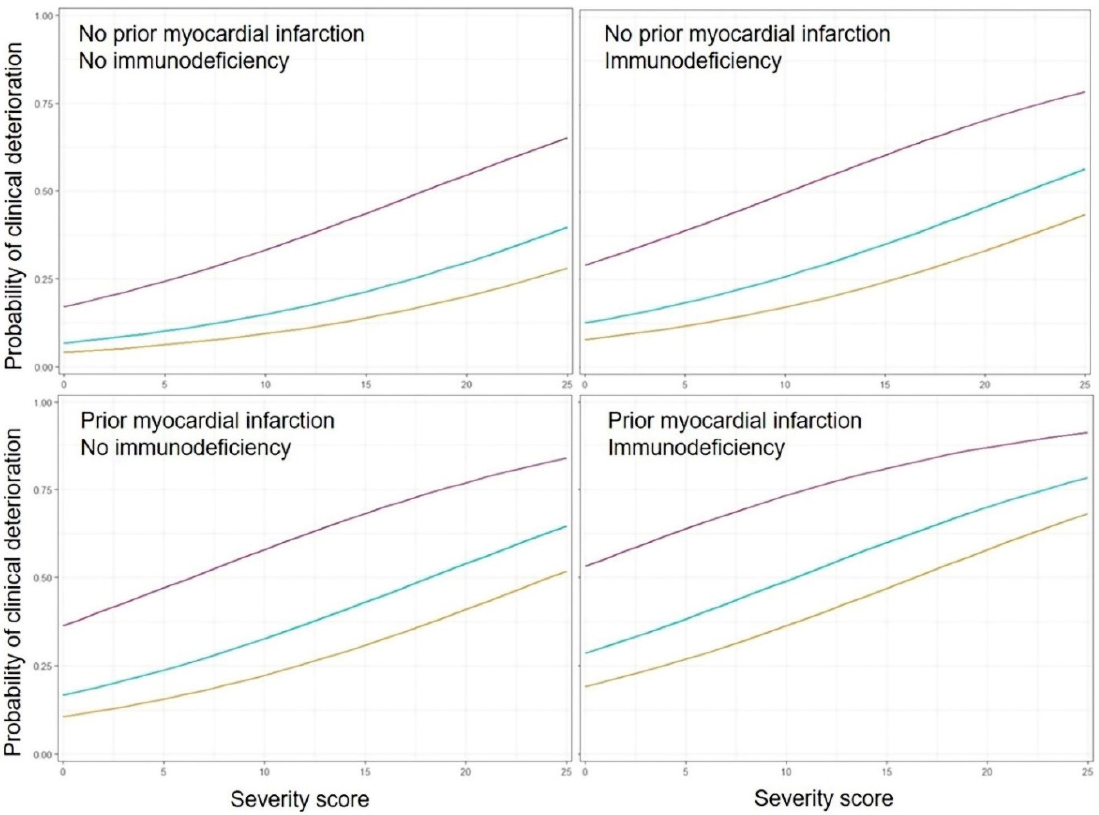
Figure A3. Deep learning-based probability plots for clinical decline as stratified by prior myocardial infarction, immuno- deficiency, CRP and AI-based CT severity score.